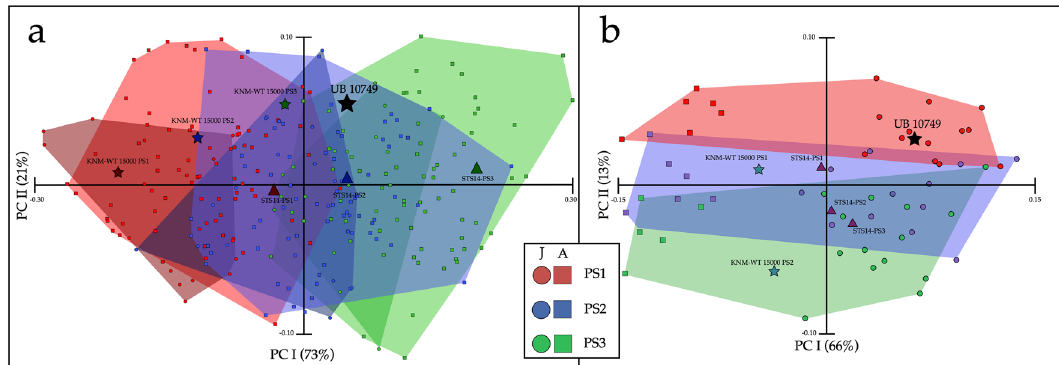
Figure 5. Serial allocation of UB 10749. ( a ) PCA of vertebral body ratios of modern humans, KNM-WT 15000, STS 14, and UB 10749 (see Supplementary Table 4). Note the overlap between adults and juvenile in each presacral vertebra. UB 10749 falls within the range of PS2–PS3. Note that KNM-WT 15000 and STS 14 follow the same pattern as modern humans. ( b ) PCA results for GM shape analysis. UB 10749 falls within the range of PS1, but with proximity to PS2. Note that KNM-WT 15000 and STS 14 follow the same pattern as modern humans. In both analysis: Circles denotes juvenile; Squares denotes adults. Red denotes PS1; Blue denotes PS2; Green denotes PS3.